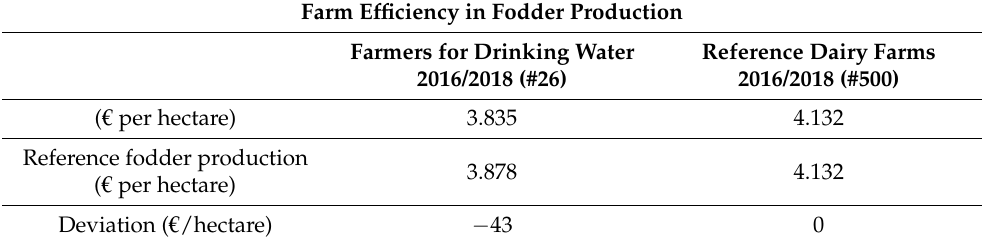
Table 2. Fodder profitability of dairy farmers from Farmers for Drinking Water compared to bench- mark